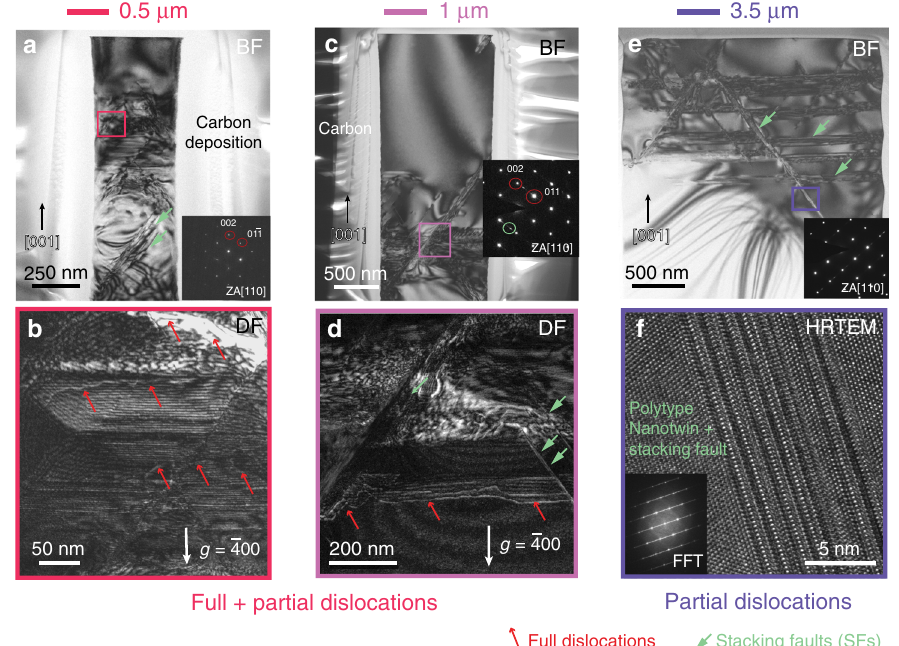
Fig. 3 TEM analyses of FIB lamellae prepared from lithographic pillars of different diameters deformed at ambient temperature. The present micrographs of all pillars were acquired in the orientations close to [110] zone axis of an Si pillar area. Images ( a , c , e ) show regions acquired in the exact [110] zone axis orientation of different size pillars embedded into an FIB deposited protective amorphous carbon cover shell. a Bright- fi eld (BF) image of 0.5 μ m diameter pillar compressed to 7% engineering strain. Stacking faults (green arrows) are observed at local area. b Weak beam dark- fi eld (WBDF) image acquired with g = (cid:1) 400 shows full dislocations (red arrows). c BF image of a lamella cut from 1 μ m diameter pillar compressed to 8% engineering strain. Twin re fl ections and streaks in the corresponding diffraction pattern (inset) con fi rms the occurrence of stacking faults (SFs) and twins. d WBDF image taken with g = (cid:1) 400 shows full dislocation traces. e BF image of 3.5 μ m pillar compressed to 6% engineering strain. f High-resolution transmission electron microscopy (HRTEM) micrograph of nanoscale twins and stacking faults inside the glide bands. This reveals structural ordering of SFs resulting in the formation of polytypes and nanotwins (see Fourier-transformation pattern